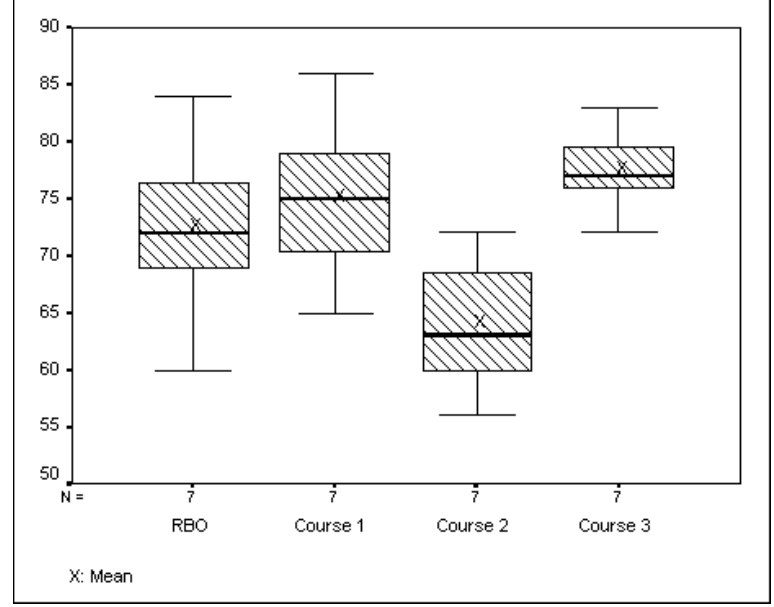
Figure 1 Box-plot of distribution of four course results of M.Ed.